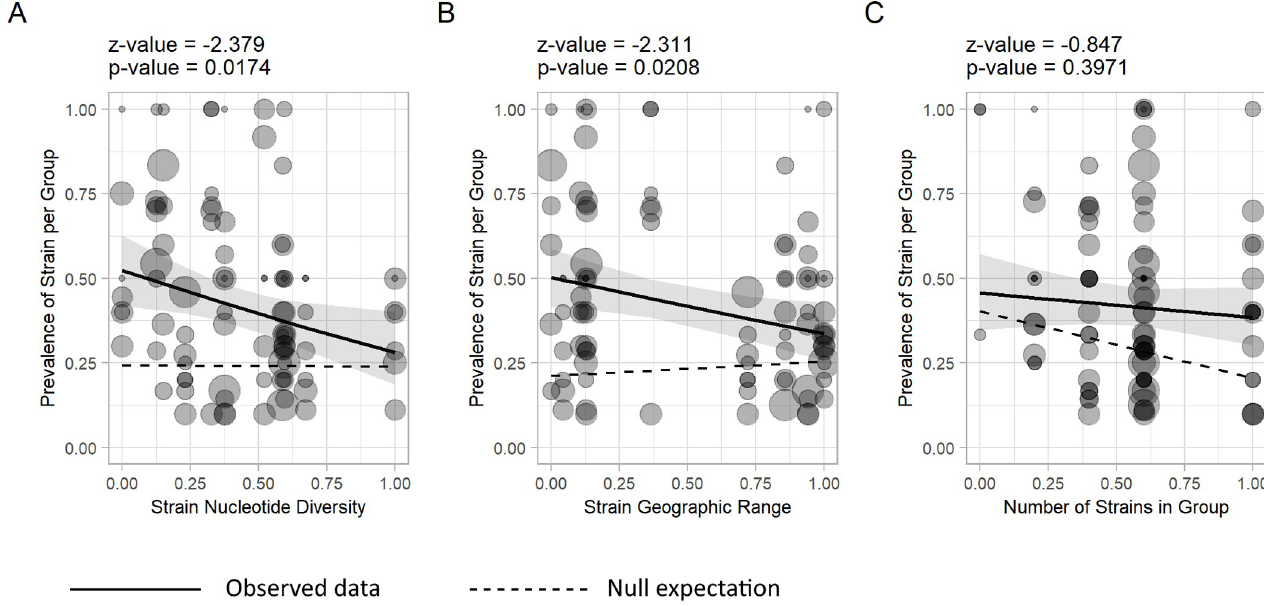
Fig 2. Relationships between strain genetic diversity, geographic range, and prevalence suggest strain emergence, spatial diffusion, and replacement. Predicted relationships between strain-specific prevalence and (A) strain nucleotide diversity, (B) geographic range, and (C) the number of strains present in each geographic group sampled (a measure of potential competition between strains). Lines and shaded areas represent the regression slope and 95% confidence intervals, respectively. Points are raw data, corresponding to the observed prevalence of each strain in each group where it occurred, with point size proportional to sample size (range = 2 to 24). The dashed lines on each graph show the null expectation, averaged over 1,000 tip randomisations. Data underlying this figure can be found in S2 Data.